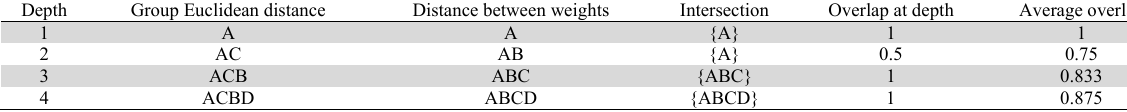
Average overlap calculation between the performance metrics (1)